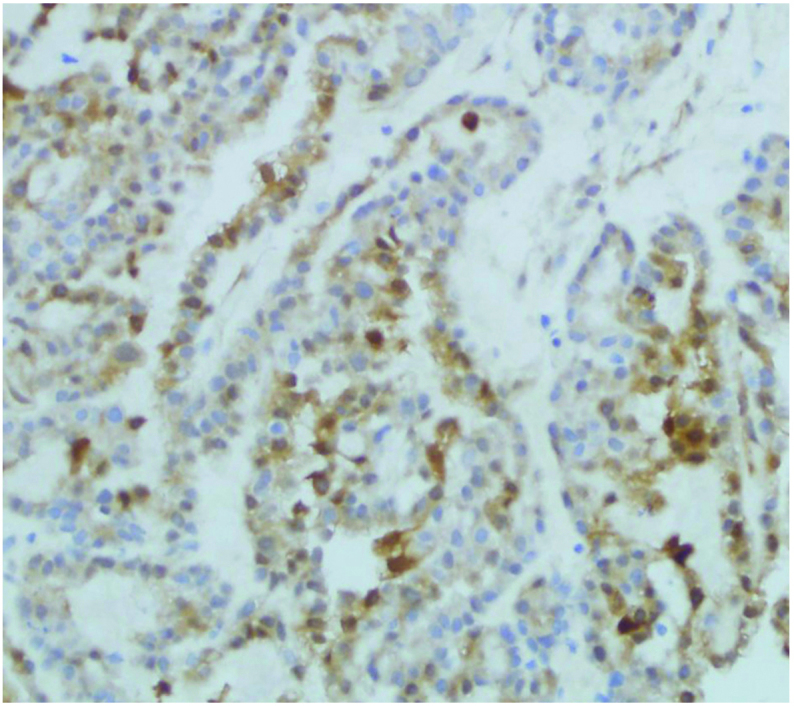
Immunohistological analysis of Snail protein in ovarian cancer tissue (magnification, ×100).